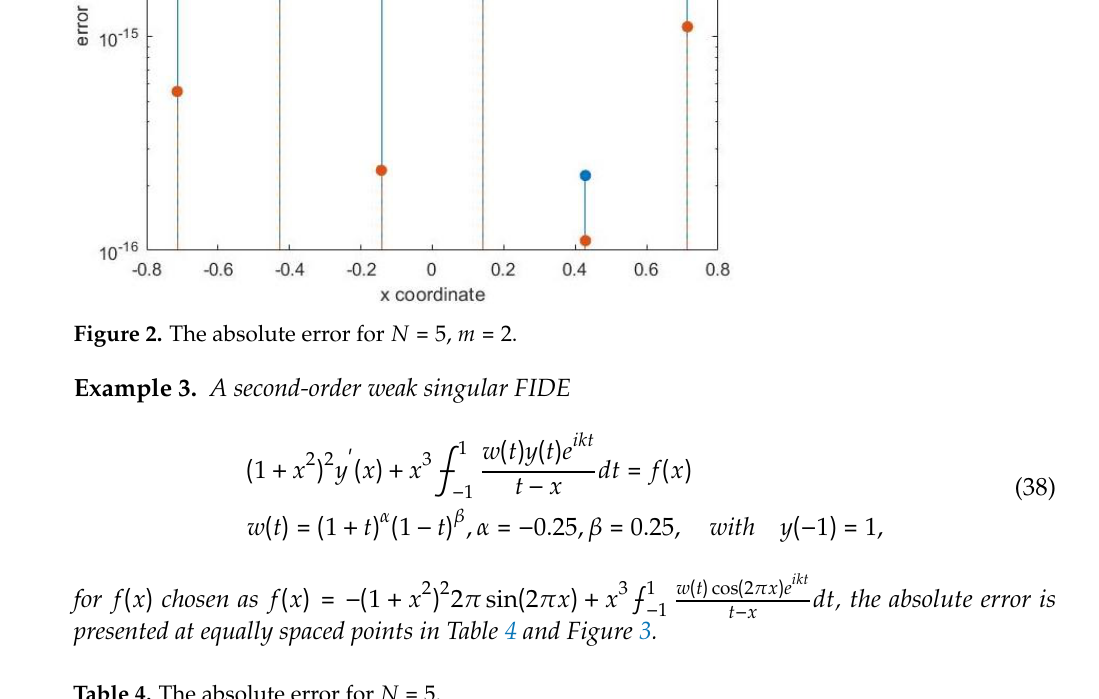
Table 4. The absolute error for N =